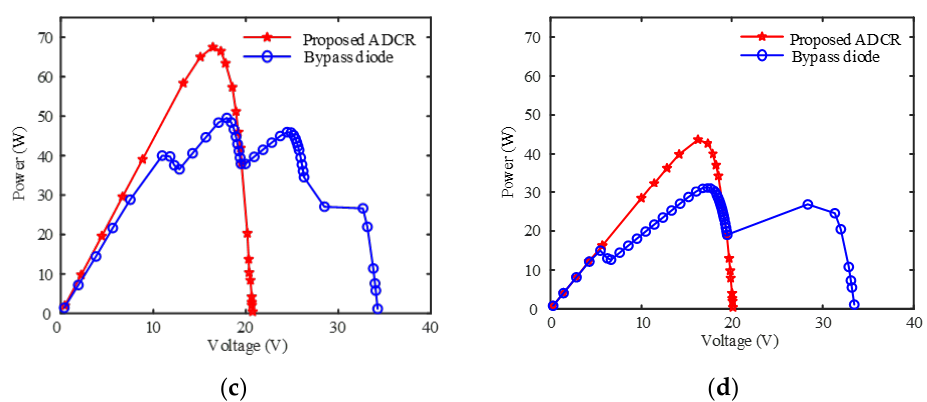
Figure 10. Power–voltage (P-V) characteristic curves for the active diffusion charge redistribution (ADCR) reconfigurable architecture and traditional bypass diode technique with series connection of five PV panels under the mismatch cases shown in Figure 9: ( a ) Case 1; ( b ) Case 2; ( c ) Case 3; ( d ) Case 4.